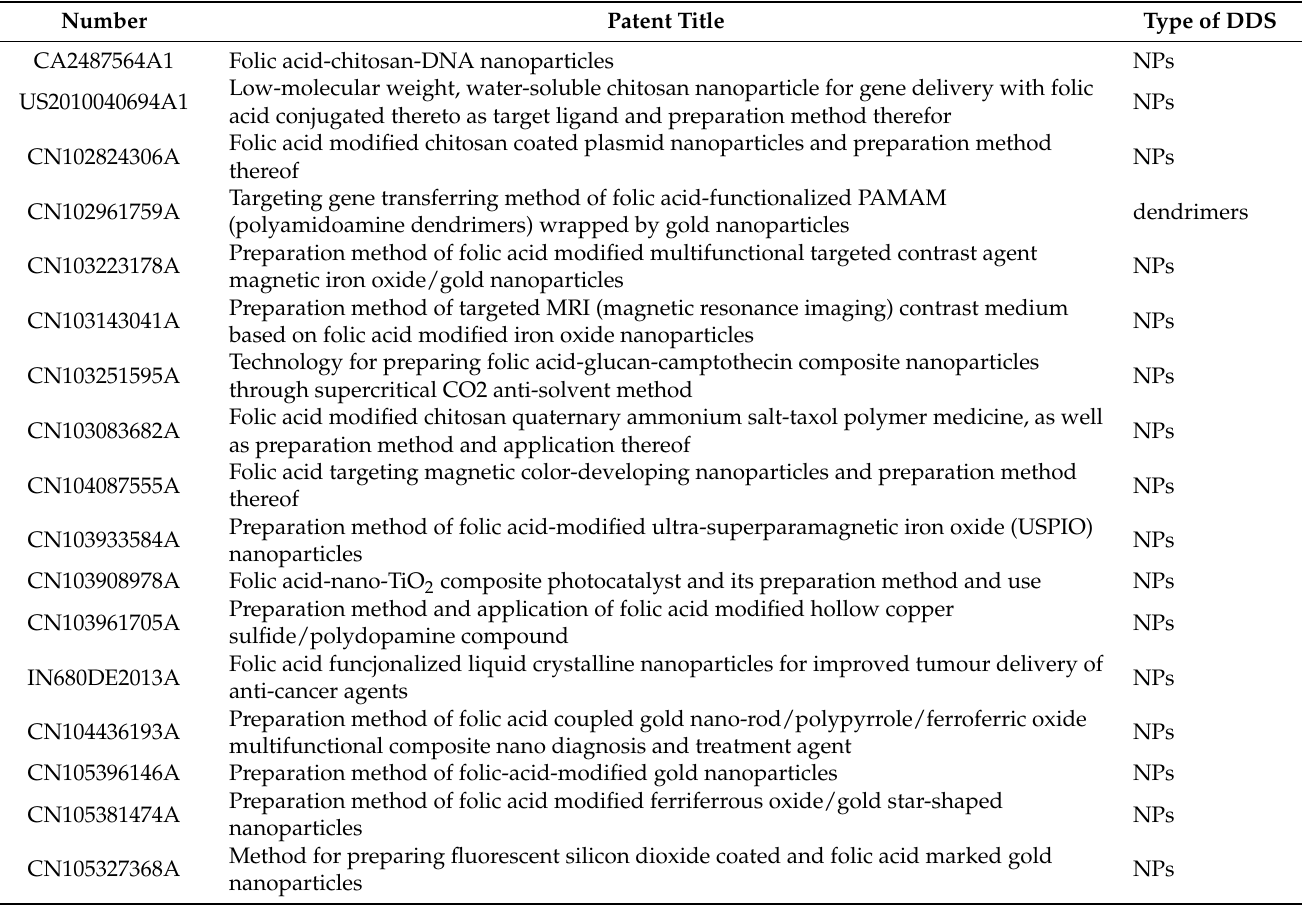
Table 3. Patented folic acid-targeted